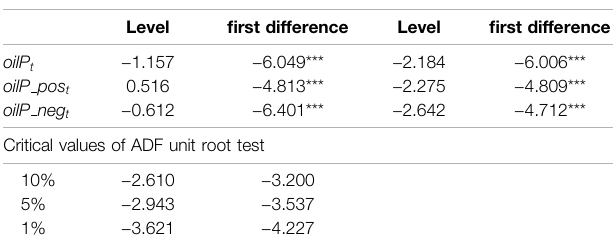
Panel B: The results of the univariate ADF unit root test